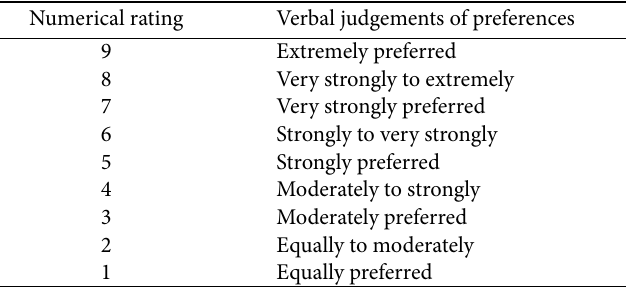
Table 2. Pair-wise comparison scale for aHP